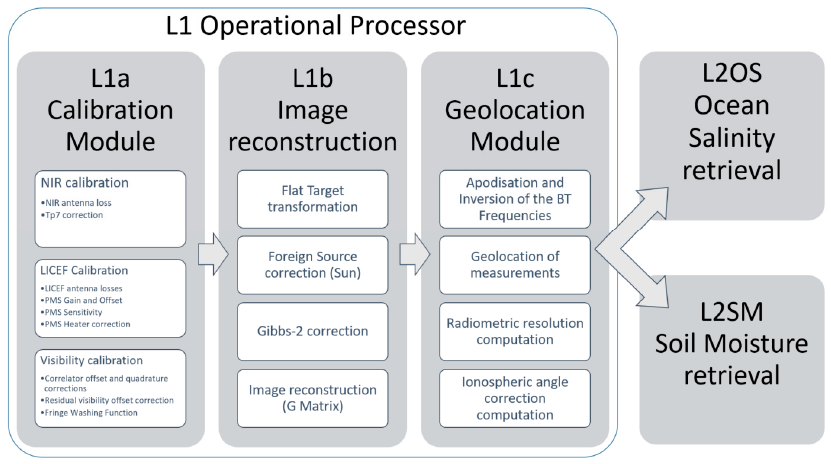
Figure 1. High-level architecture of the SMOS Operational processing baseline.